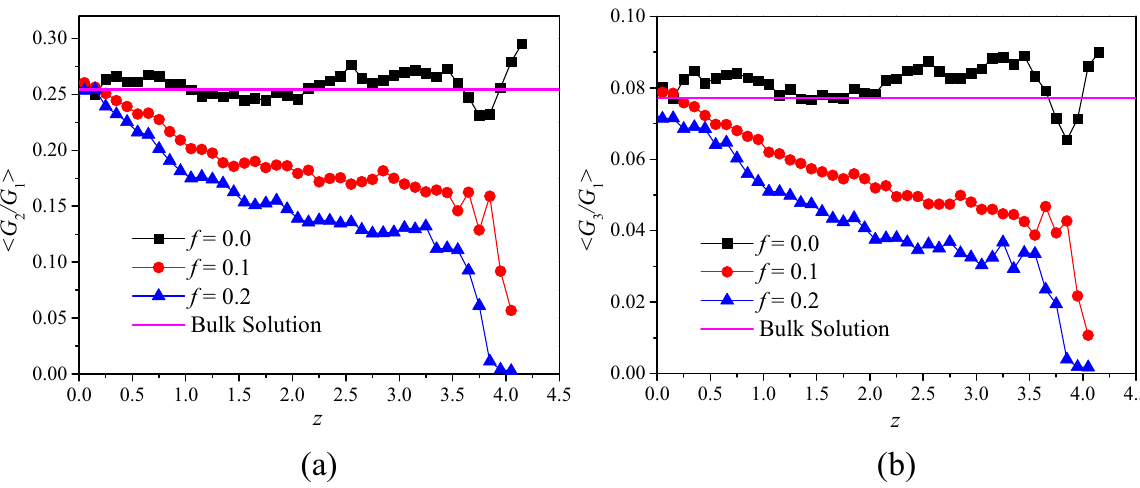
Figure 6: The average eigenvalue ratio distribution across the slit for the driving force f = 0, 0.1, and 0.2, and for bulk solution at equilibrium: ( a ) 〈 G G 〉 and ( b ) 〈 G G 〉 2 / 1 3 / 1